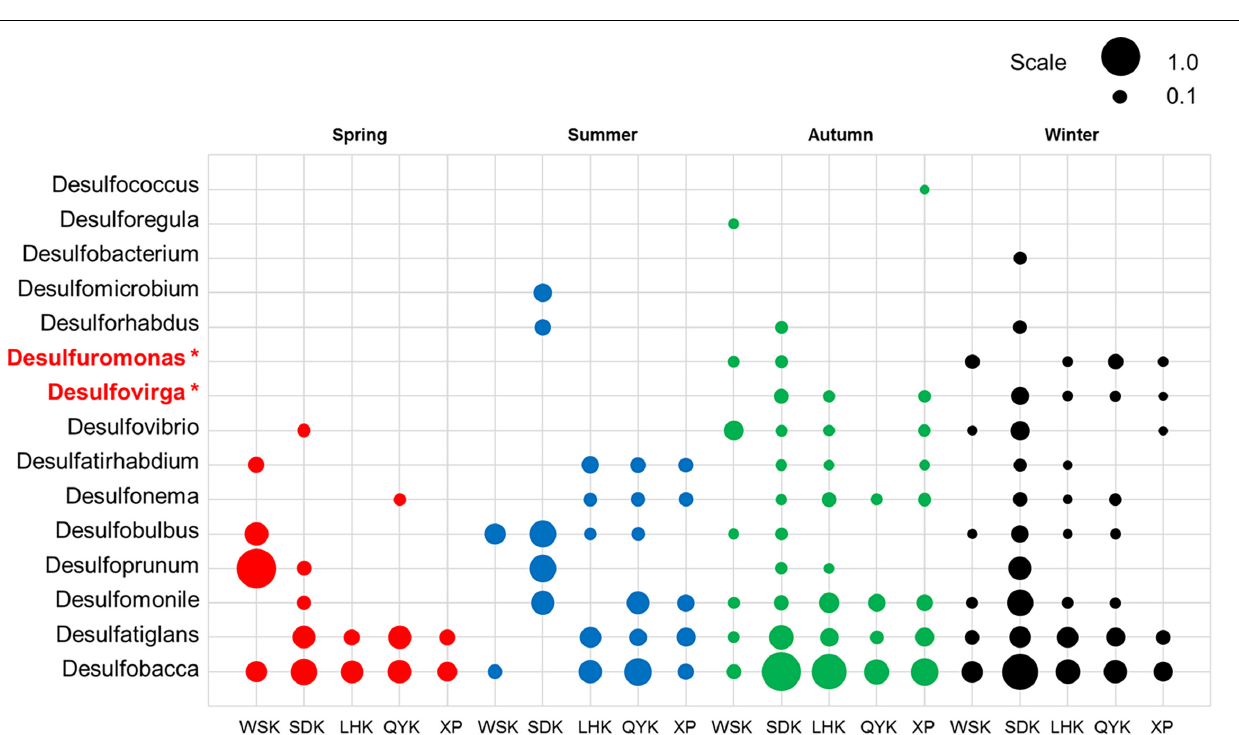
FIGURE 5 | Relative abundances of sulfate/sulfur-reducing bacterial genera in sediments from different sampling sites among various seasons (Red = Spring, Blue = Summer, Green = Autumn, Black = Winter). Asterisks represent a significant difference among the seasons according to Kruskal-Wallis H-test from STAMP pipeline (Kruskal-Wallis H-test, P < 0.05).